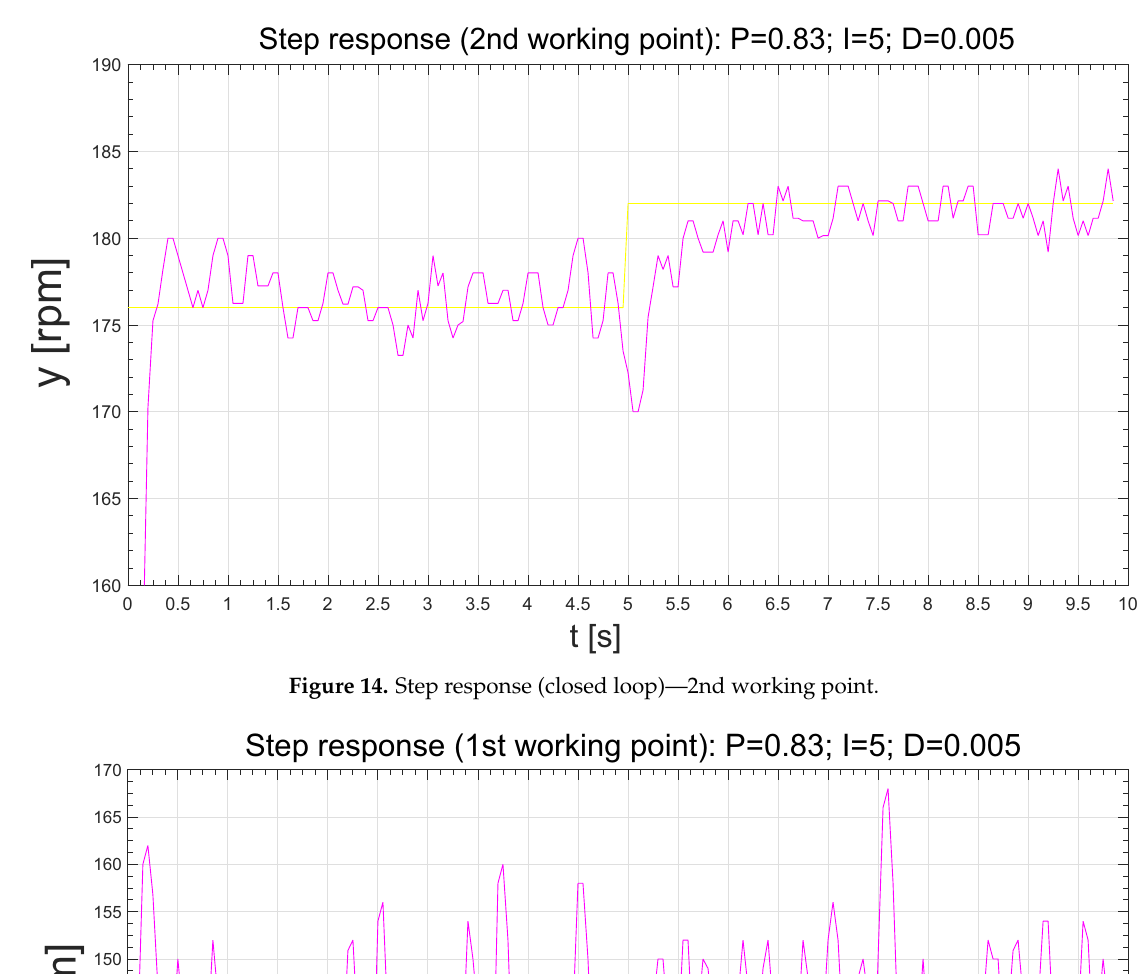
Figure 14. Step response (closed loop)—2nd working point.